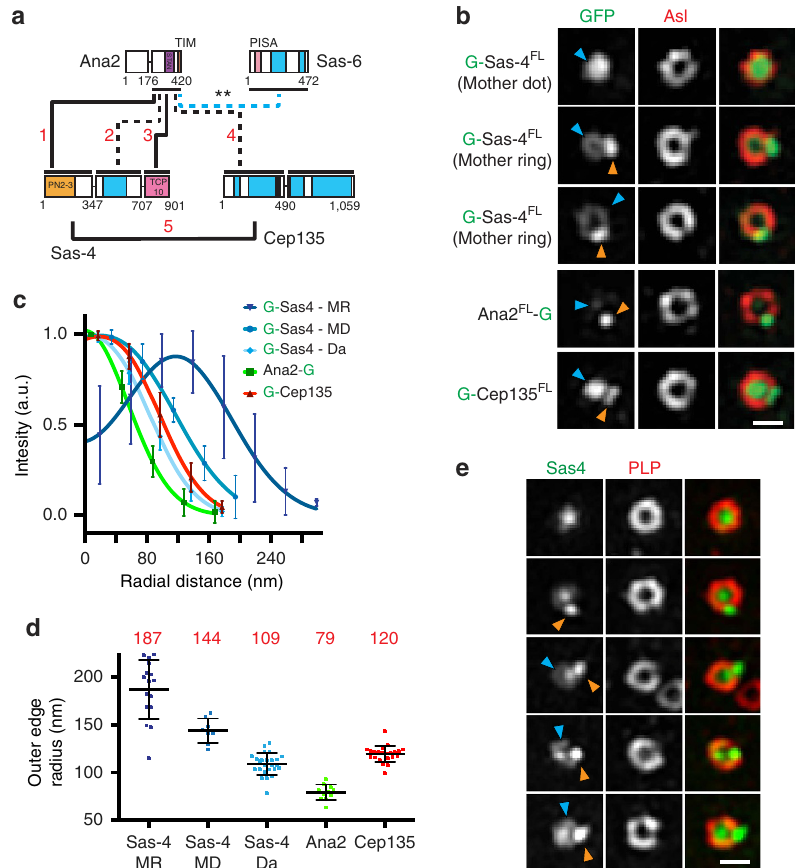
Figure 2 | Centriole–protein interactions reveal dynamic and stable components. ( a ) Interactions (red numbers) among core centriole proteins. Black numbers are amino acids, blue regions are predicted coiled-coils, horizontal lines indicate the locations where proteins were subdivided, dark black lines are interactions scoring 2 or 3, dashed lines scored 1 and blue dotted line indicates a phosphorylation-dependent interaction (Fig. 6d) 16,17 . ( b ) SIM of centrioles from S2 cells expressing GFP::Sas-4. Sas-4 presents as dots or rings in mothers and only as dots in daughters. Ana2 is always a dot. Cep135 N-term forms small rings. Blue arrowheads, mother. Orange arrowheads, daughter. ( c ) Averaged intensities of linescans across centrioles aligned from the centriole centre and moving out. Lines are fits to average data. Error is ± s.d. Ns are centrioles, Sas-4 (MR, mother ring) ¼ 16, Sas-4 (MD, mother dot) ¼ 8, Sas-4 (Da, daughter) ¼ 25, Ana2 ¼ 11, Cep135 ¼ 22 from two experiments. ( d ) Outer edge measurements showing the mean (red number) of individual fits of data in c ± s.d. ( e ) SIM of centrioles in wing discs from transgenic flies expressing Sas-4::GFP. Similar to in S2 cells Sas-4 occupies a variety of positions within centrioles in the wing disc. Scale bars,